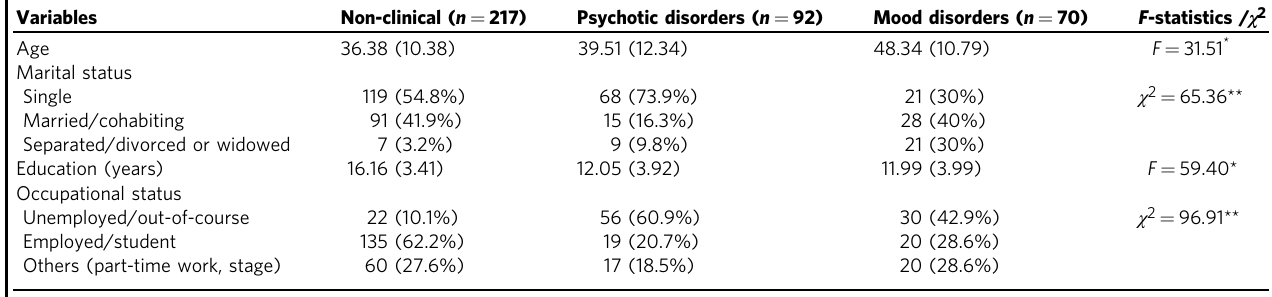
Table 1 Demographic characteristics of the clinical and non-clinical samples.